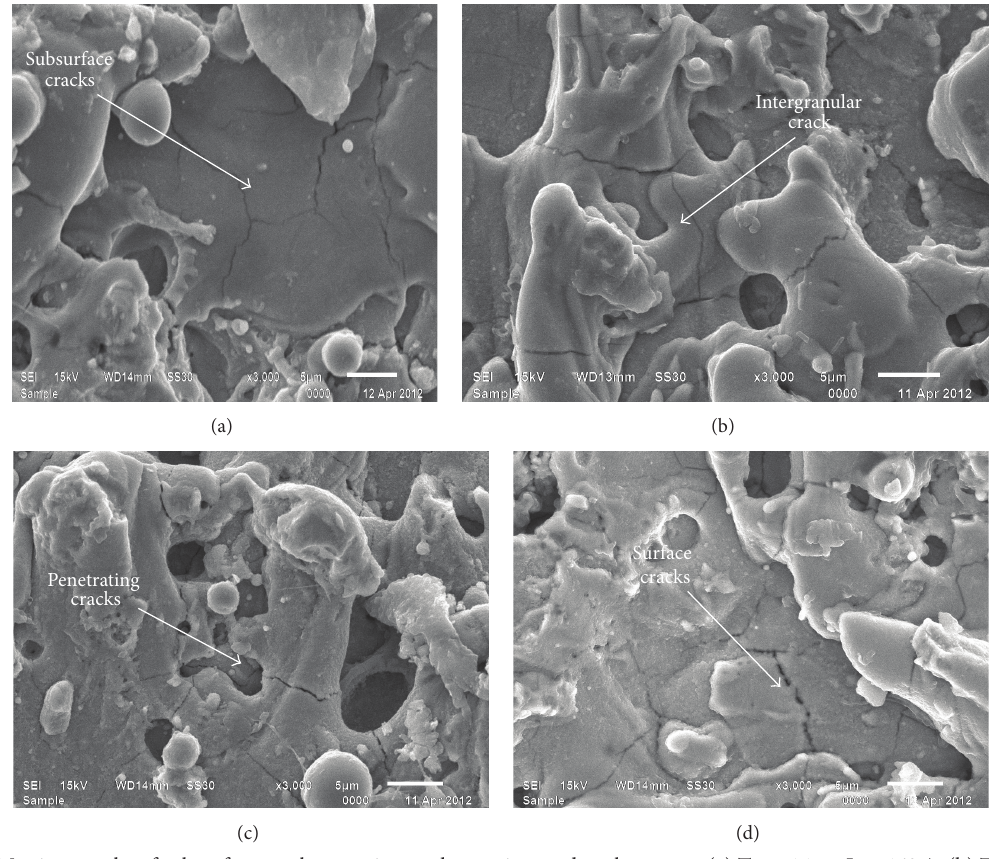
Figure 7: SEM micrographs of subsurface cracks at various pulse on time and peak current: (a) 𝑇 on = 1.1 𝜇 s, Ip = 160A, (b) 𝑇 on = 1.1 𝜇 s, Ip = 200 A, (c) 𝑇 on = 0.9 𝜇 s, Ip = 120A, (d) 𝑇 on = 0.9 𝜇 s, Ip = 160A.